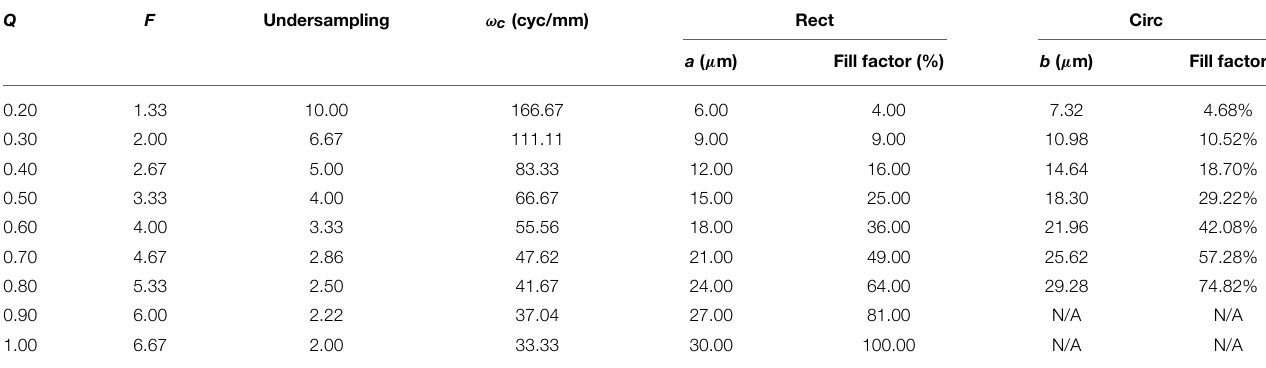
The pitch is assumed to be p = 30 μ m and λ = 4.5 μ